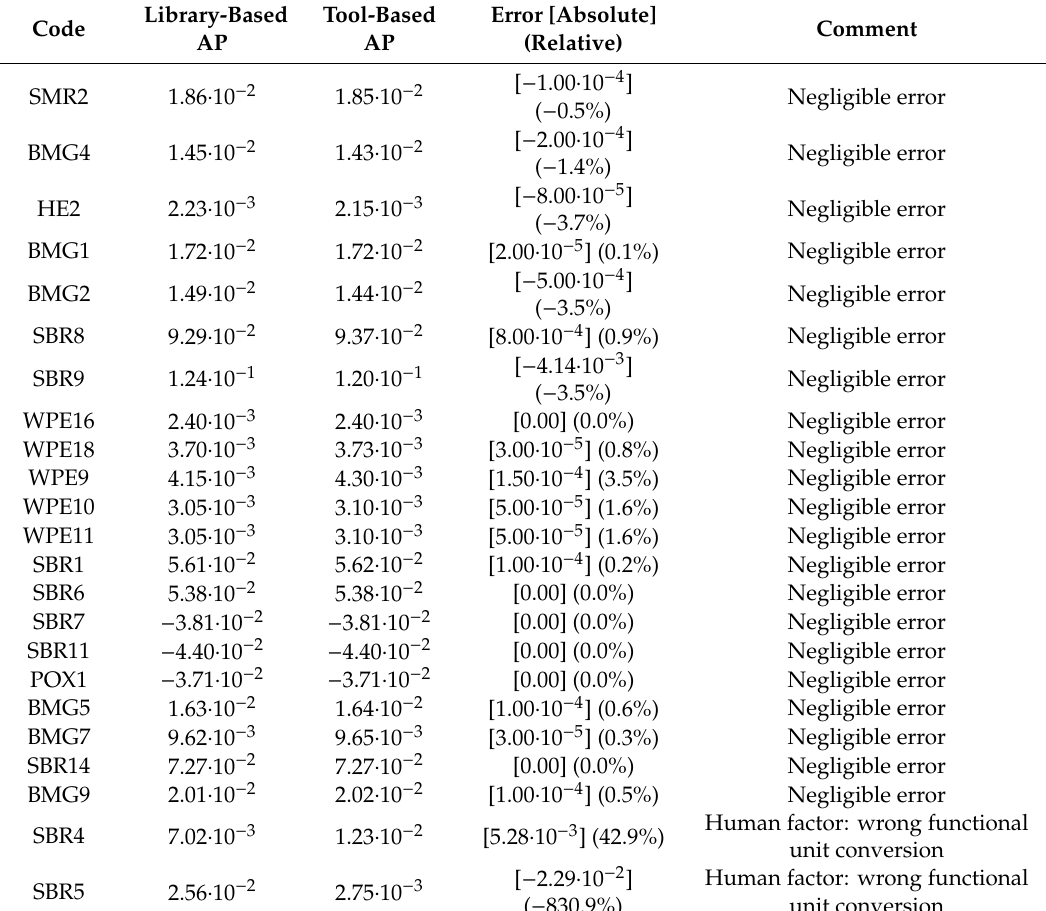
Table 3. Library- and tool-based harmonised acidification of hydrogen (kg SO 2 eq per functional